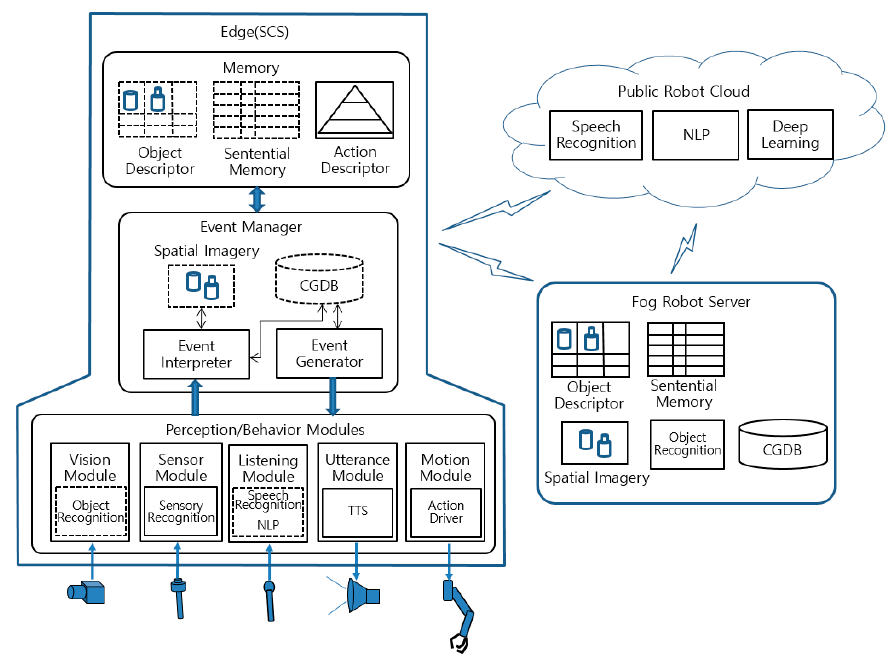
Figure 5. The block diagram of the sentential cognitive system (SCS) based on FaaS-FR that offloads the computation of modules. CGDB: cognitive grammar database; TTS: text-to-speech.